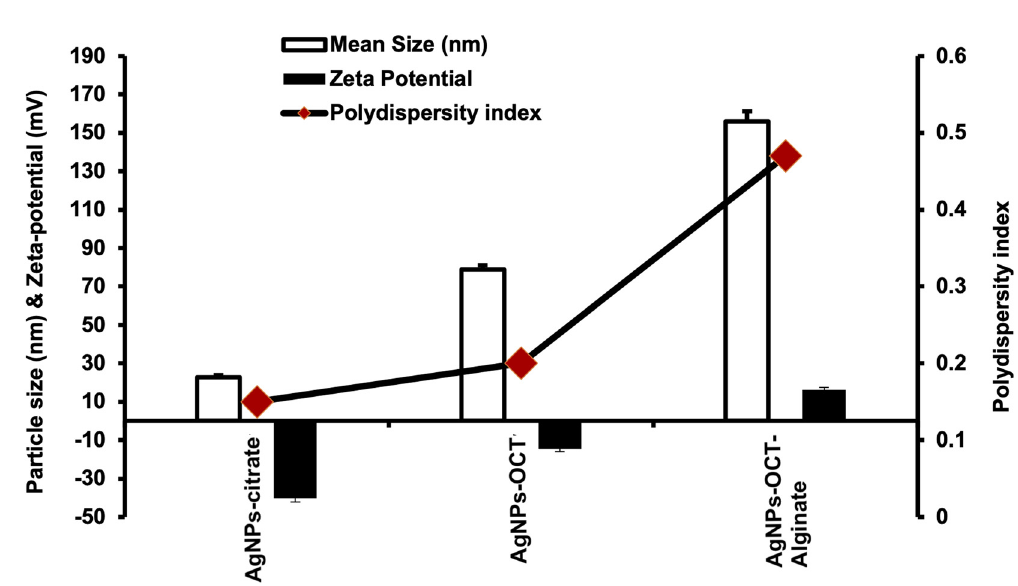
Figure 2: Size distributions ( nm ) , ζ potentials ( mV ) , and polydispersity indices of the AgNPs – CTT, AgNPs – OCT, and AgNPs – OCT – Alg.